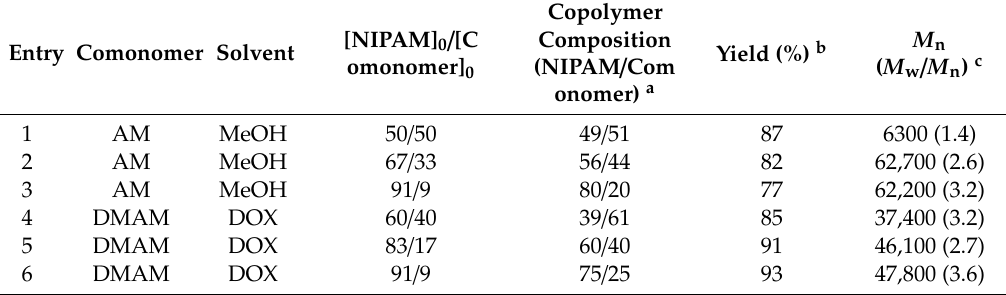
Table 2. Synthesis of P(NIPAM- co -AM) and P(NIPAM- co -DMAM) by radical polymerization of NIPAM and